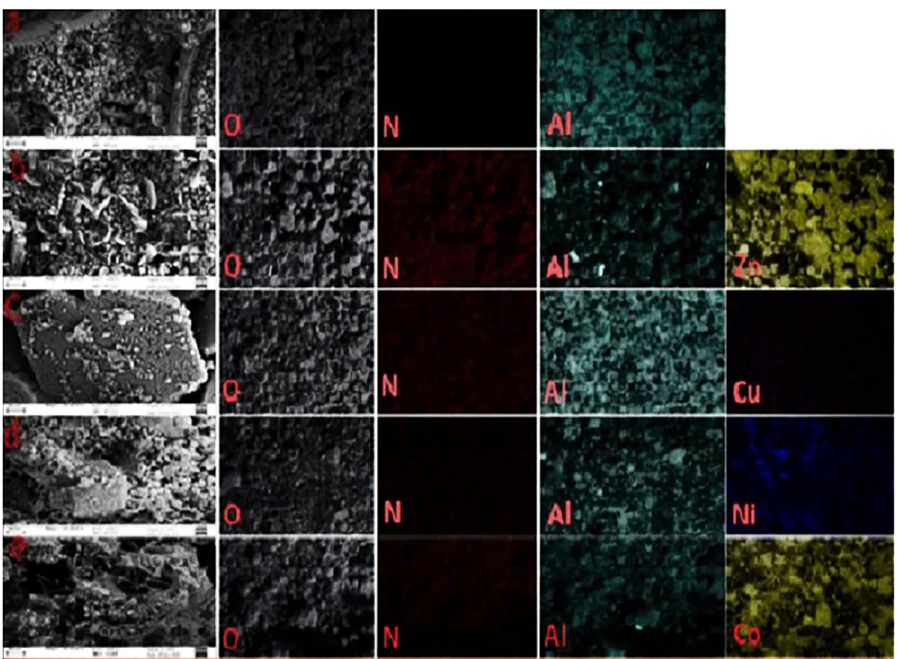
Figure 3. FE-SEM of Al 2 O 3 NP s , ZnAl 2 O 4 , CoAl 2 O 4 , NiAl 2 O 4 , and CuAl 2 O 4 nanocomposites at 1100